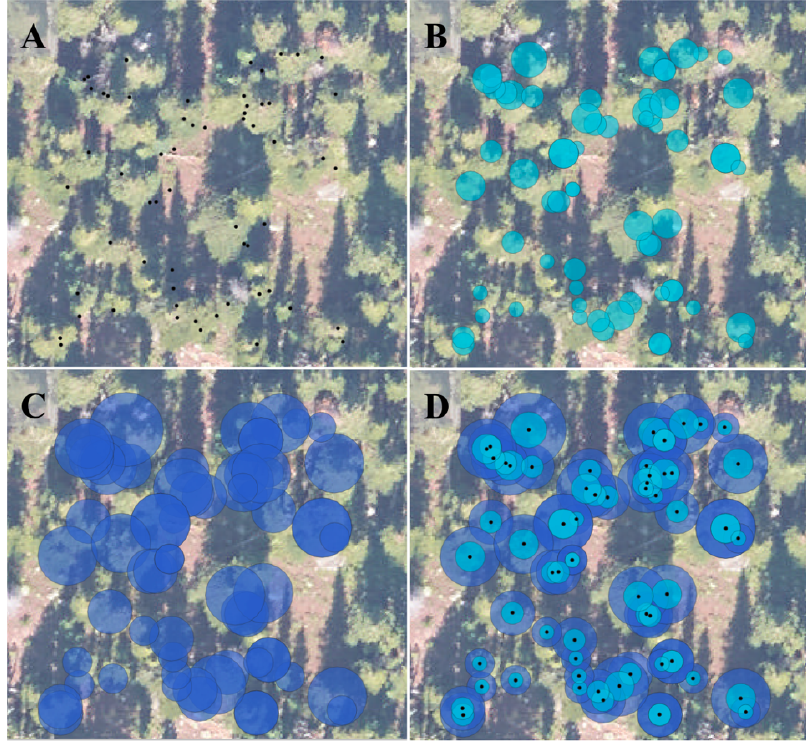
Figure 4. “Raw” reference data sets created using all of the input woody vegetation measurements at the NIWO_015 distributed base plot with dimensions of 20 × 20 m, located at 451146 m East, 4432366 m North: ( A ) Tree stem points. ( B ) Circular polygons created with half the maximum crown diameter for each tree. ( C ) Circular polygons created with the maximum crown diameter for each tree. ( D ) All of these points and polygons are displayed together. Polygons are displayed with 50% opacity to help illustrate the areas of overlap between adjacent polygons, as well as the presence of multi-bole entries which appear opaque where multiple identical polygons are present. The base layer is RGB image data collected by the AOP with 10 cm spatial